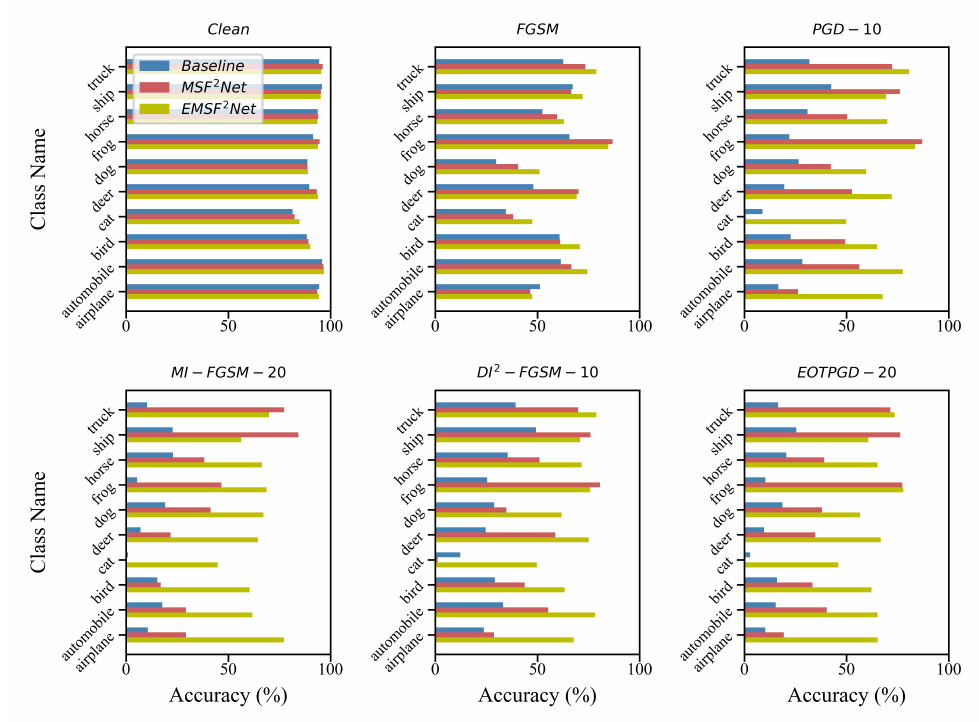
Figure 4. Clean and robust accuracies under L ∞ -norm attacks of the three methods on each class of the CIFAR-10 dataset. The X-axis and Y-axis of each sub-figure represent the robust accuracy and class name of CIFAR-10, respectively.